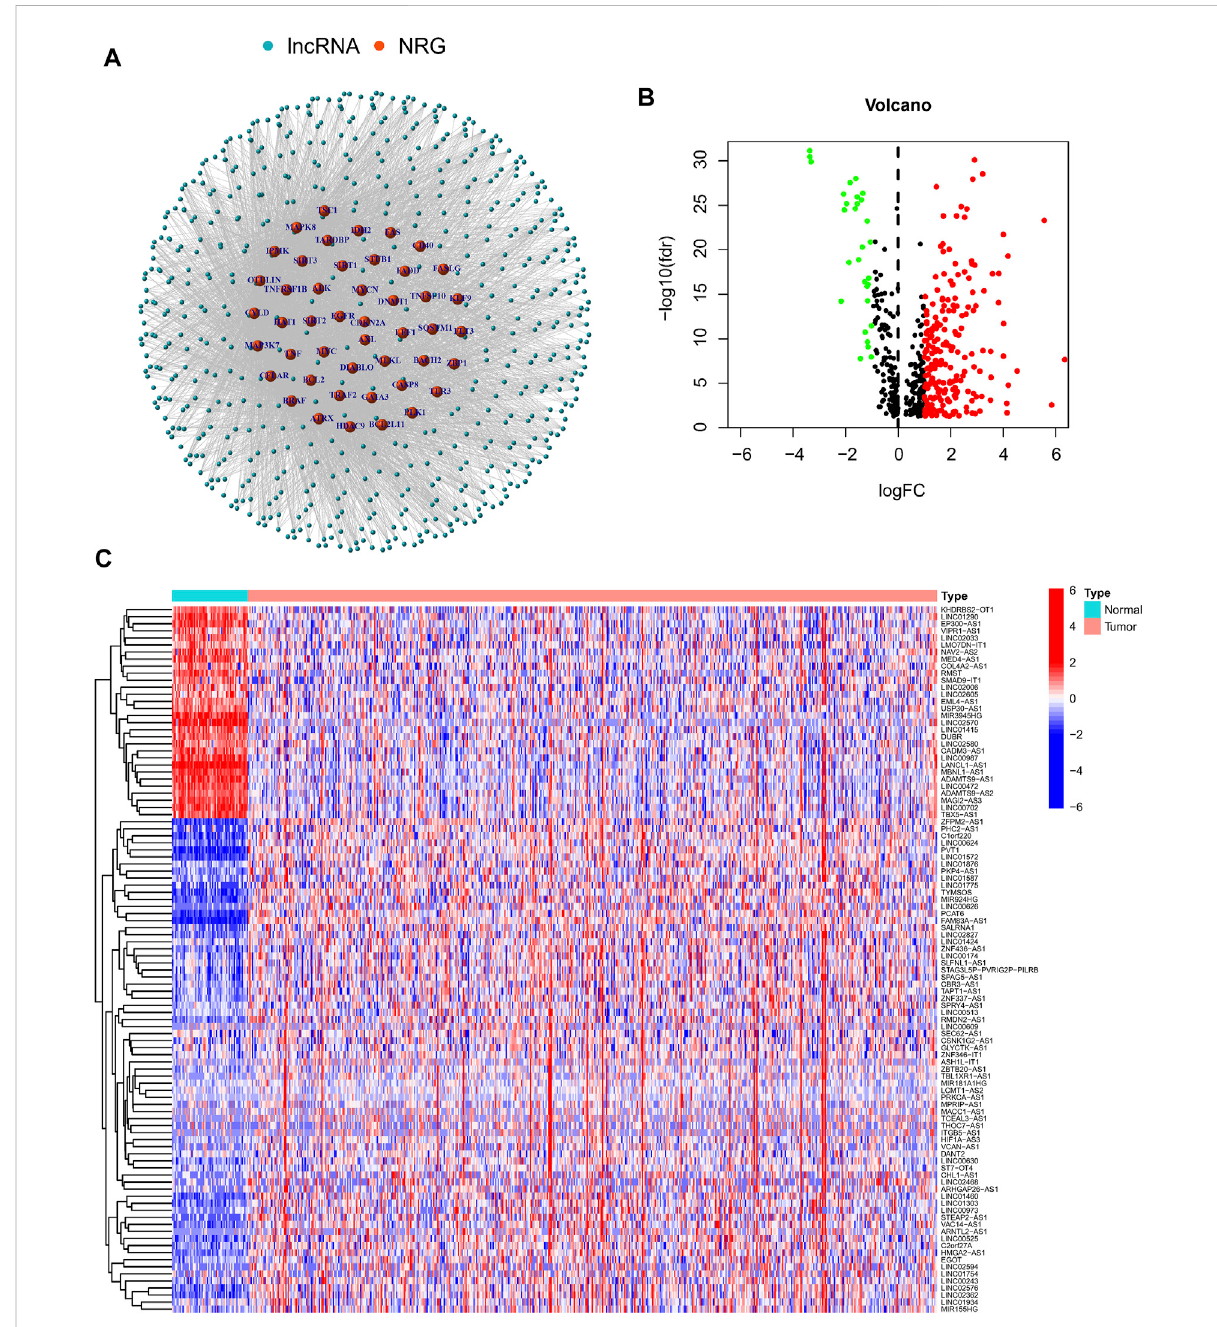
FIGURE 2 Identi fi cationof differentially expressed necroptosisNRlncRNAsinLung adenocarcinoma. (A) A co-expression network ofthe586NRlncRNAs- mRNA was constructed and visualized by using “ igraph ” R package. (B,C) . The volcano plot and heatmap showed the differentially expressed NRlncRNAs in tumor and normal